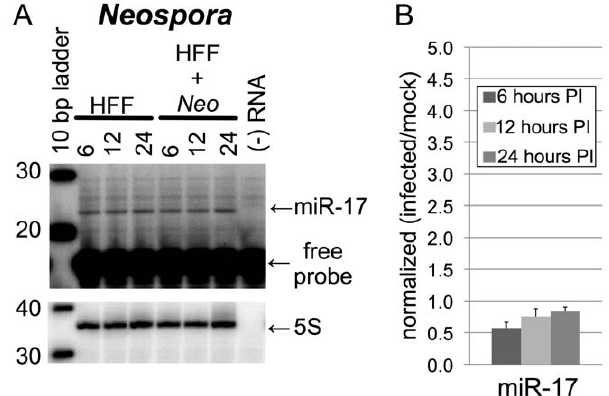
Figure 3. Neospora infection does not alter the levels of miR-17 family members. (A) Total RNA samples were extracted from HFFs during a 24-hour timecourse of Neospora- infection, and subject to primer extension analysis. From left to right, template RNAs were derived from uninfected HFFs at 6, 12 or 24 hours, or from infected HFFs at the same time points. Shown are representative autoradio- graphs for primer-extension with the miR-17 and 5S probes; reactions were performed on biological triplicates. miR-17 and 5S probes were